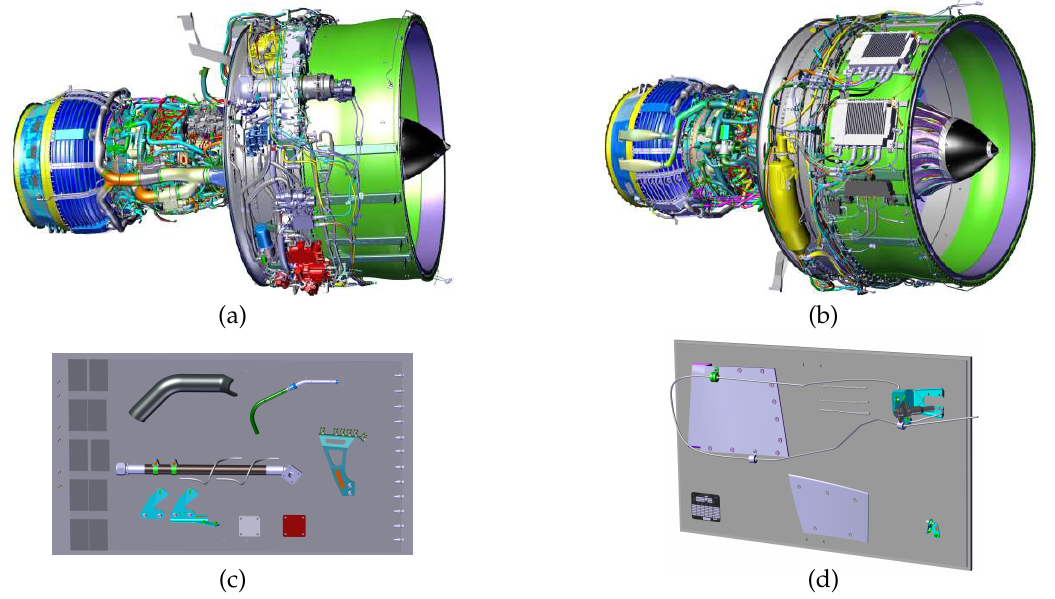
Figure 4. Some of our CAD models: ( a , b ) aircraft engine, ( c , d ) two testing plates with several elements.